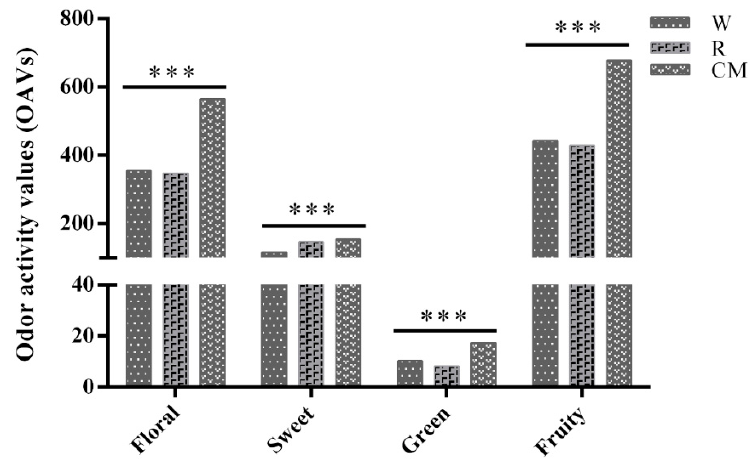
Figure 1. The impact of different fermentation technologies on the odor activity values (OAVs) of the odorant series for Muscat Hamburg wine. *** p < 0.001.